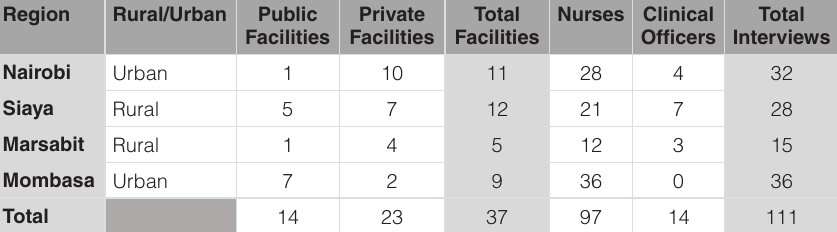
Table 7. Description of facilities and interviews conducted by study